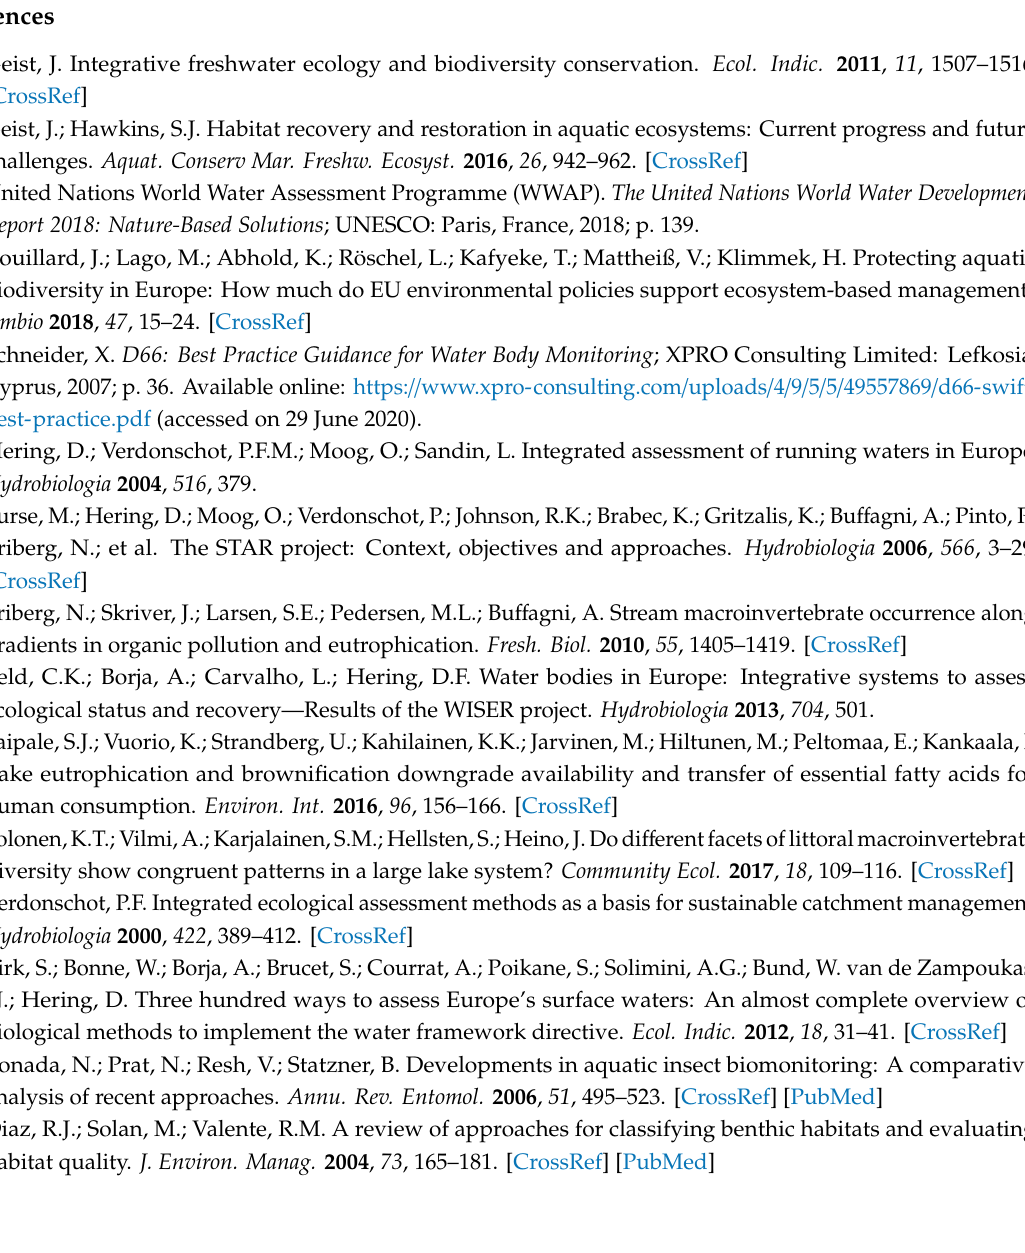
Table S1: The Dataset with all the measurements for each single site within a lake, including lake name, site name, season, depth, temperature, oxygen, pH, conductivity, alkalinity, TP, TN, percentage of sand, percentage of silt, percentage of clay, water content, organic matter, carbonates, mineral content, richness of Chironomidae, richness of Oligochaeta, overall species richness, Shannon Diversity Index (SDI), and BQIES single-site , LHMS, and LHQA. ‘NA’ means not